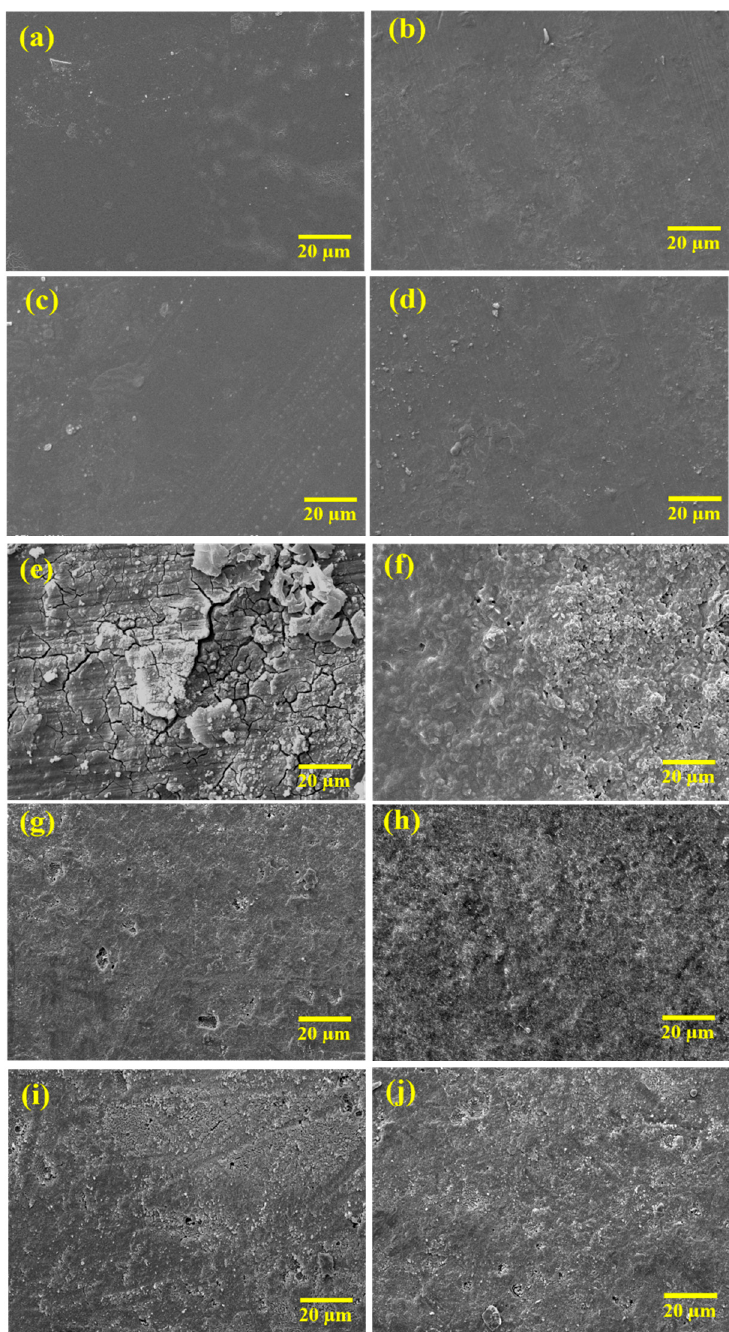
Figure 12. SEM images of prepared coatings ( a ) PU/EP5V, ( b ) PU/10PPy, ( c ) PU/20PPy, ( d ) PU/30PPy, and ( e ) bare, ( f ) PU/Bare, ( g ) PPy/EP5V, ( h ) PU/10PPy, ( i ) PU/20PPy, ( j ) PU/30PPy after immersion in 3.5% NaCl